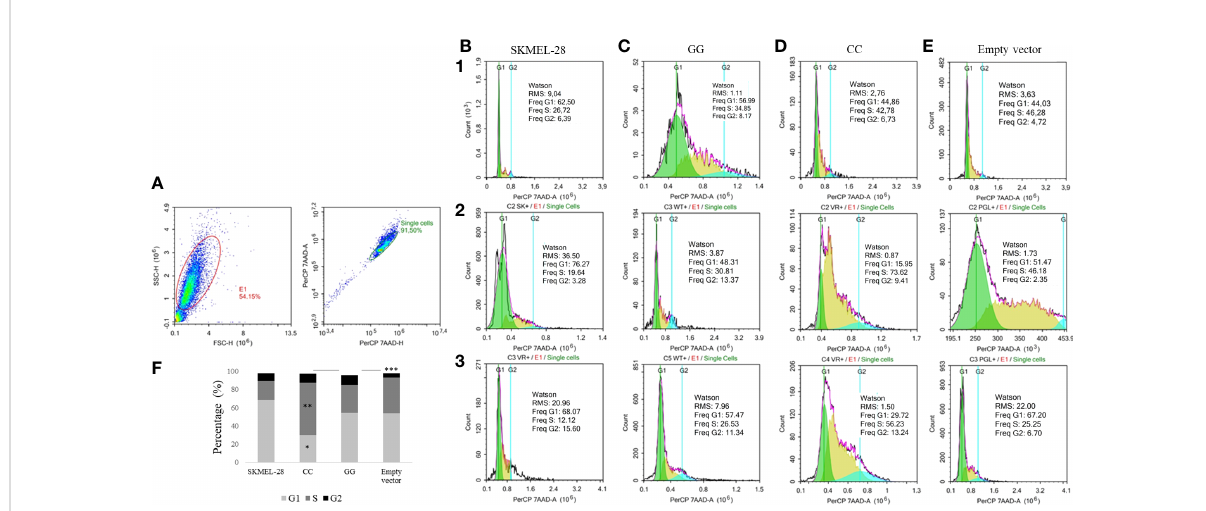
FIGURE 4 Cell cycle detection by fl ow cytometry in a SKMEL-28 cutaneous melanoma cell genetically modi fi ed to present the different genotypes of STAT3 c.- 1937C>G. The cells were stained with the 7-AAD antibody for cell viability. Three independent experiments were performed (1, 2, and 3). The identi fi cation of the cells was carried out from the separation by size (FSC) and granularity (SSC). Afterwards, the removal of the doublets was carried out through the area (A) and the height (H) (A) . From the individualized cells, the fl uorescence intensity of 7-AAD and the separation of phases G1, S, and G2 of the cell cycle of experiments one to three were evaluated using the Watson model in SKMEL-28 (B) , cell with GG genotype (C) , cell with CC genotype (D) , and cell transfection with empty vector (E) . For the statistical tests, values with p < 0.05 were considered signi fi cant. The results are shown as means between groups: CC vs. GG (G1: 30.18 vs. 54.26%, * p = 0.05; S: 57.54 vs. 30.73%, ** p = 0.04; G2: 9.79 vs. 10.96%, p = 0.65), CC vs . empty vector (G1: 30.18 vs. 54.23%, p = 0.09; S: 57.54 vs. 39.24%, p = 0.18; G2: 9.79 vs. 4.59%, p = 0.08), and GG vs. empty vector (G1: 54.26 vs. 54.23%, p = 0.99; S: 30.73 vs. 39.24%, p = 0.31; G2: 10.96 vs. 4.59%, *** p = 0.03) (F)